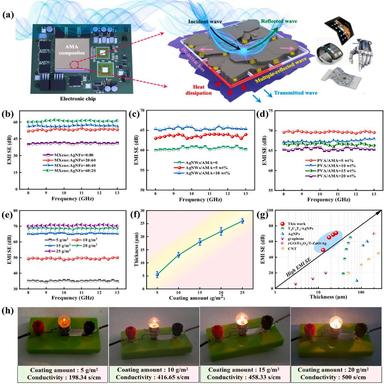
(a) Mechanism and application of AMA composites. (b) The effects of the ratio of MXene to AgNFs on EMI SE of AMA composites. (c)The effects of AgNWs content on EMI SE of AMA composites. (d) The effects of PVA content on EMI SE of AMA composites. (e) The effects of coating amount on EMI SE of AMA composites. (f) Relationship between coating amount and material thickness. (g) The comparison between the materials prepared in this study and the latest electromagnetic shielding materials. (h) Ele